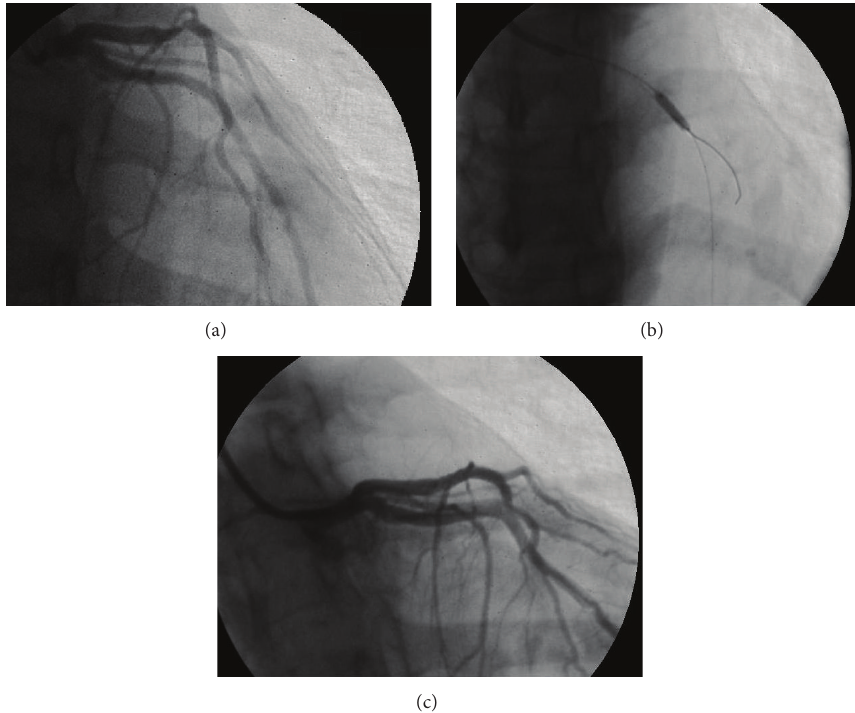
Figure 3: Cardiac catheterization study. (a) Marked stenosis of the anterior descending coronary artery can be seen in the upper left corner. (b) A catheter containing the deflated balloon is advanced through the restriction. (c) After balloon angioplasty and drug-eluting stent placement, contrast dye is injected again to verify complete dilatation of the stenosis.